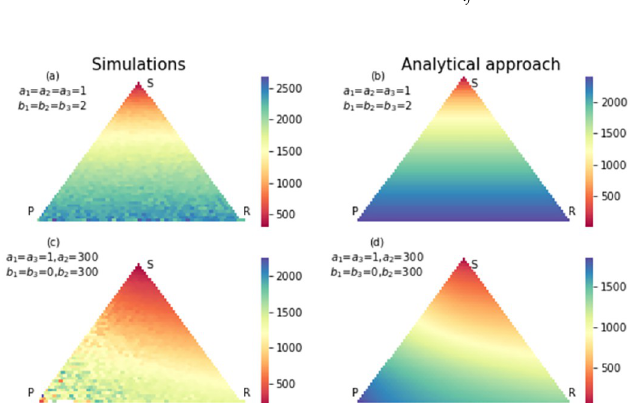
Fig 6. The simulation (a) and analytical (b) results for fixation probability of strategy scissors in an RSP game with neutral selection. The size of the population is 50. The states close to absorption state P = 0, S = N , R = 0 have a higher chance of absorbing in this absorption state. In (c) and (d) same results were shown with a strong selection in favor of paper strategy and detriment of rock strategy. Compared to the neutral case, some states are close to P = 0, S = 0, R = N but have a high chance to absorb in P = 0, S = N , R = 0 strategy. The reason is imposing strong selection to the detriment of rock